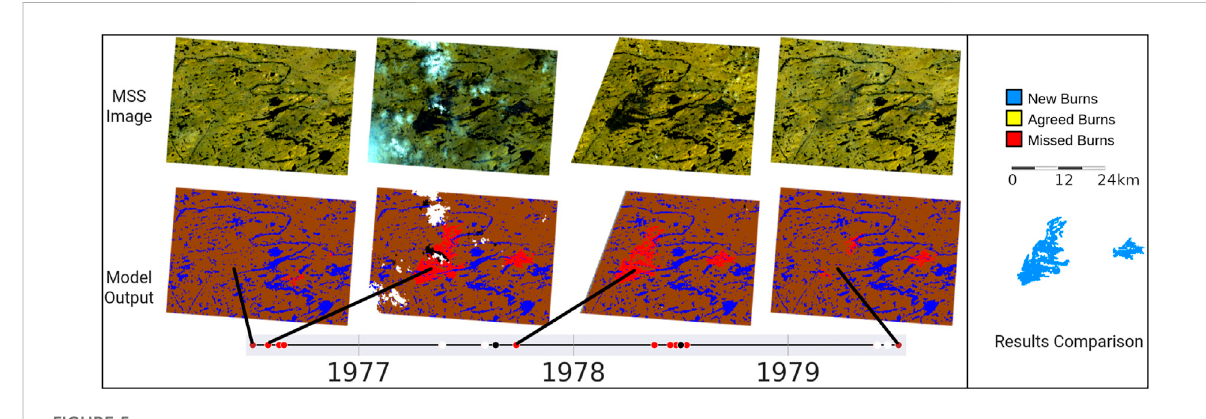
FIGURE 5 Results Detail C. MSS images and model classi fi cations of a newly detected fi re, along with a timeline of each model classi fi cation for a single pixel.